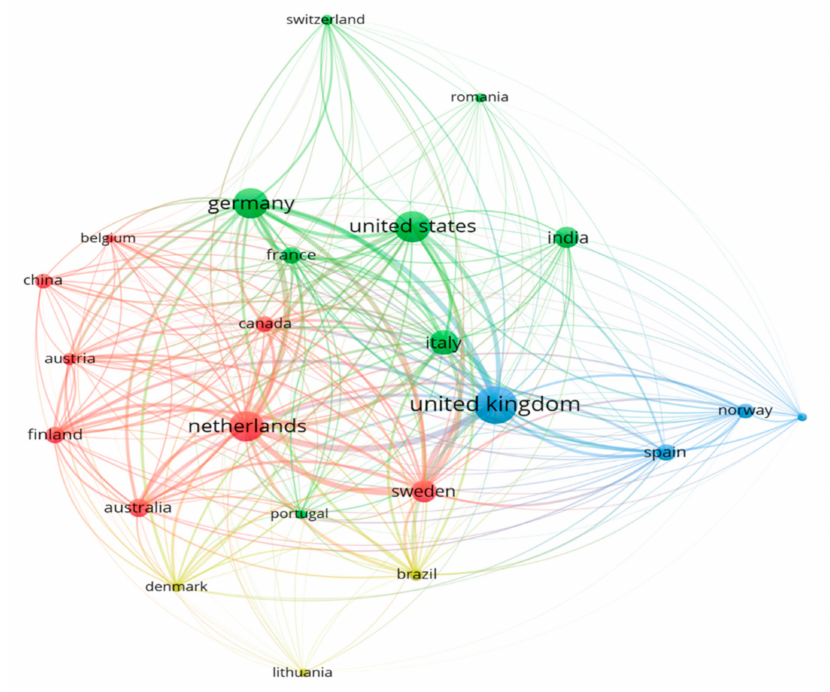
Figure 6. Bibliographic coupling of countries that publish in sustainable business models research. Source: own elaboration based on the VOSviewer